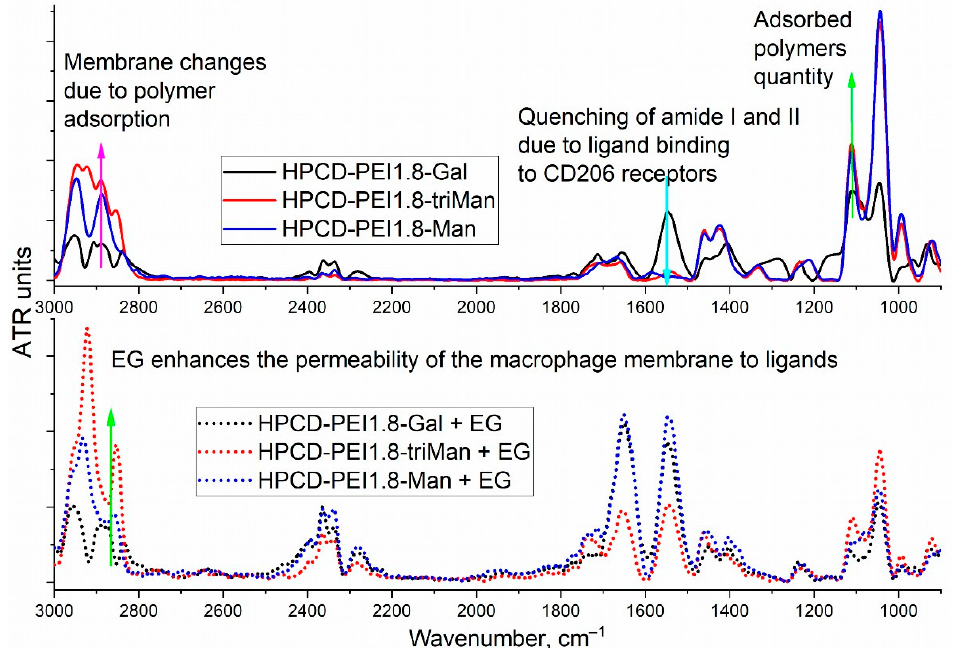
Figure 4. FTIR spectra of CD206+ Macrophages with absorbed E. coli incubated with drug delivery systems with different carbohydrate vectors and eugenol-enhanced formulations.